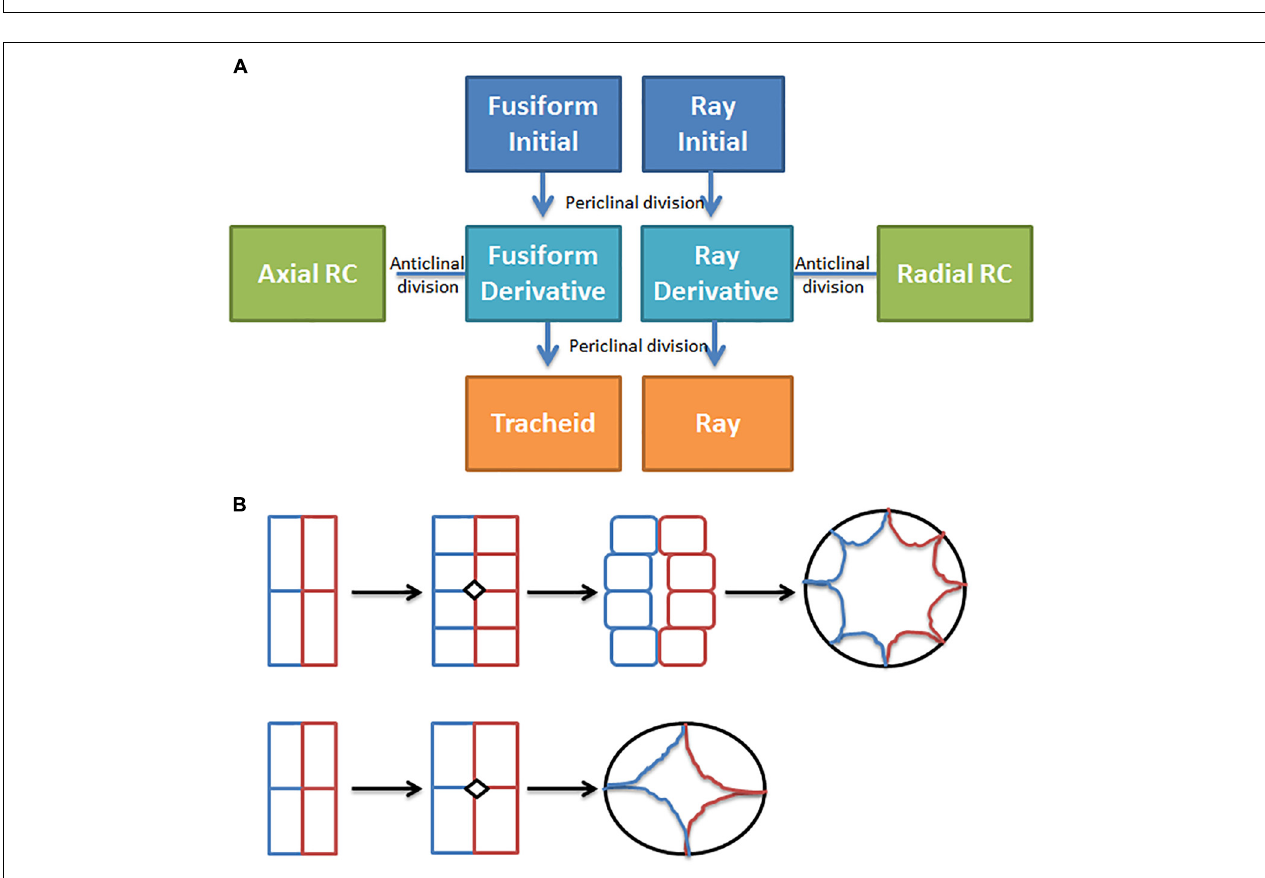
FIGURE 1 | Resin duct organization and induction. (A) A theoretical three dimensional model depicting the interconnectivity of constitutive axial and radial resin ducts in woody stems of Pinaceae; (B) Transverse cryosection of an untreated 1-year-old loblolly pine stem, stained with safranin red, showing constitutive axial and radial resin ducts in the wood and cortical resin duct in the bark (Peter, 2018, Unpublished); (C) Transverse cryosection of 1-year-old loblolly pine stem 10 days after treatment with 10 mM methyl jasmonate (Martin et al., 2002), stained with safranin red showing newly formed axial traumatic resin ducts in the cambial zone/young xylem (Peter, 2018,